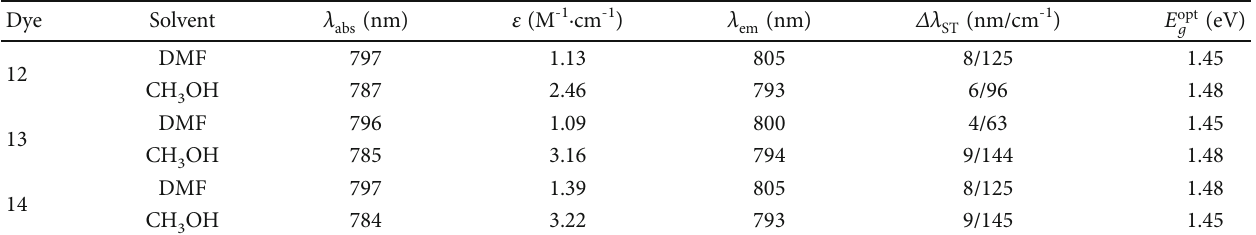
and λ are the absorption and emission wavelengths, respectively; ε abs em is the Stokes shift; and E opt is the optical bandgap. ST g